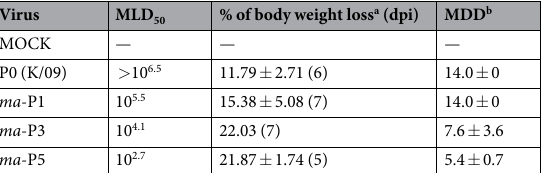
Table 1. Pathological findings from the mice infected with the K/09 and ma viruses. a The mean maximum body weight losses and b mean day of death (MDD) were obtained from the mice infected with 10 5 PFU. Each result was expressed in average with ± standard deviations (SD).